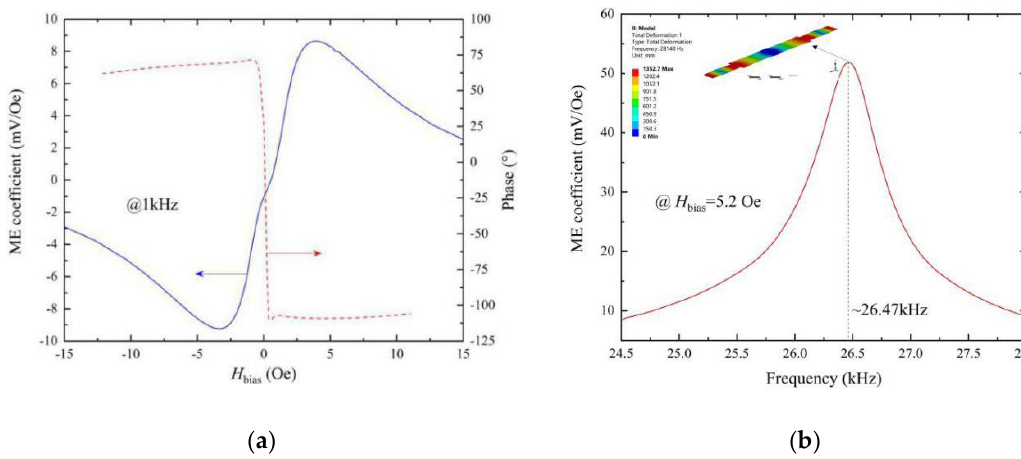
Figure 2. The ME voltage coefficient of the FeCuNbSiB/piezofiber laminates: ( a ) ME coefficient α ME as a function of the bias magnetic field H bias in response to a ~1 kHz sine driving magnetic field, and ( b ) α ME as a function of the AC sine magnetic drive frequency sweeping through the electromechanical resonance.